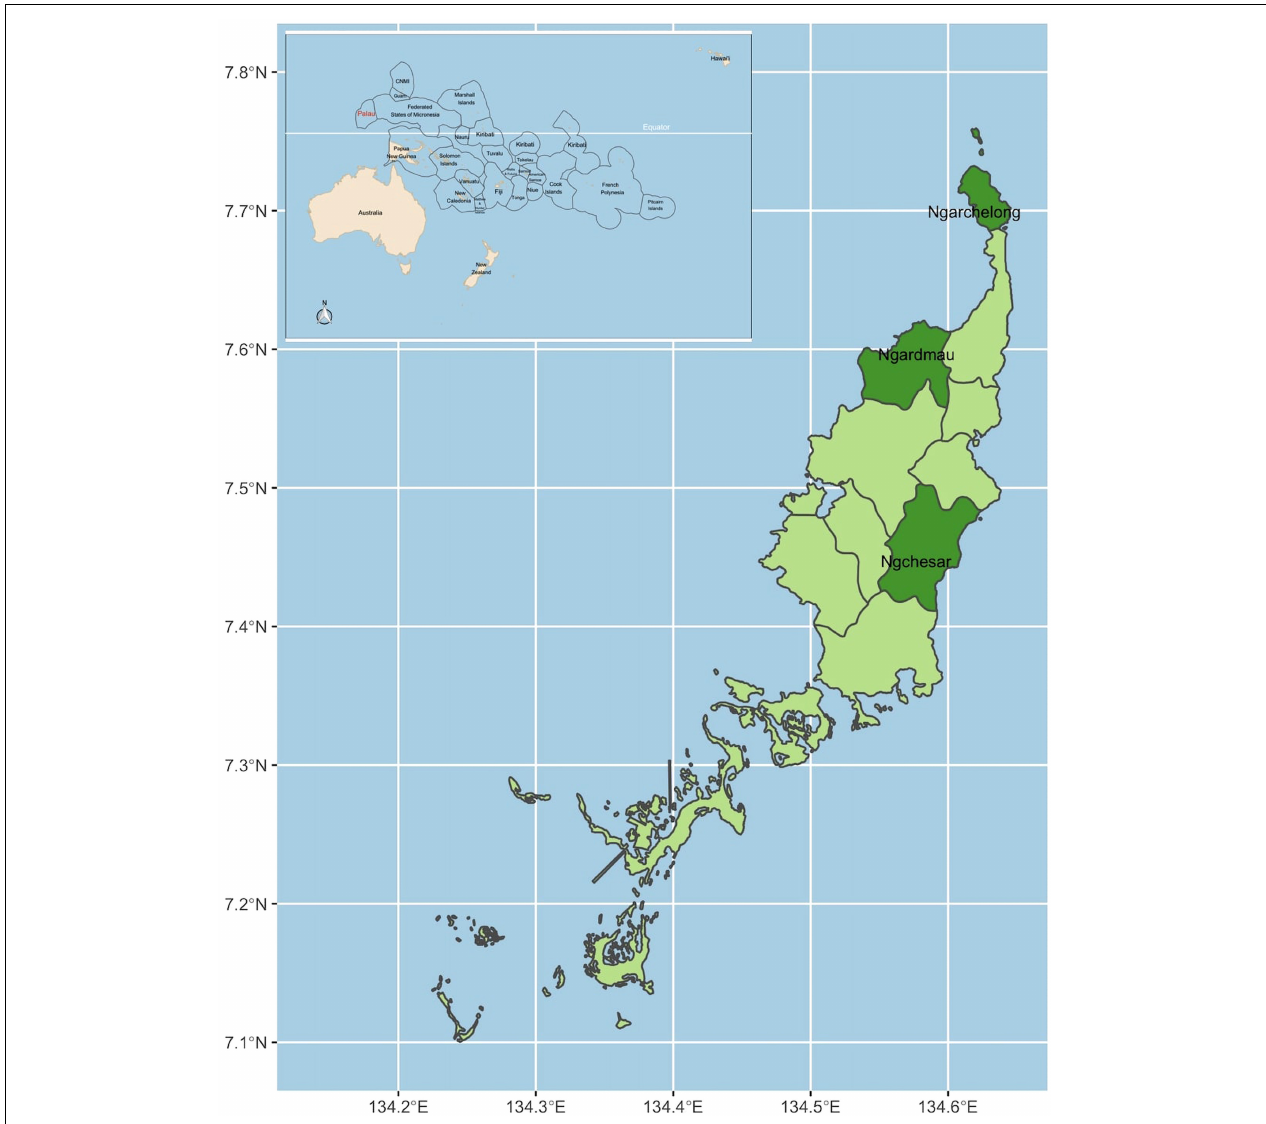
FIGURE 1 | Map of mainland Palau. Study sites are shown in dark